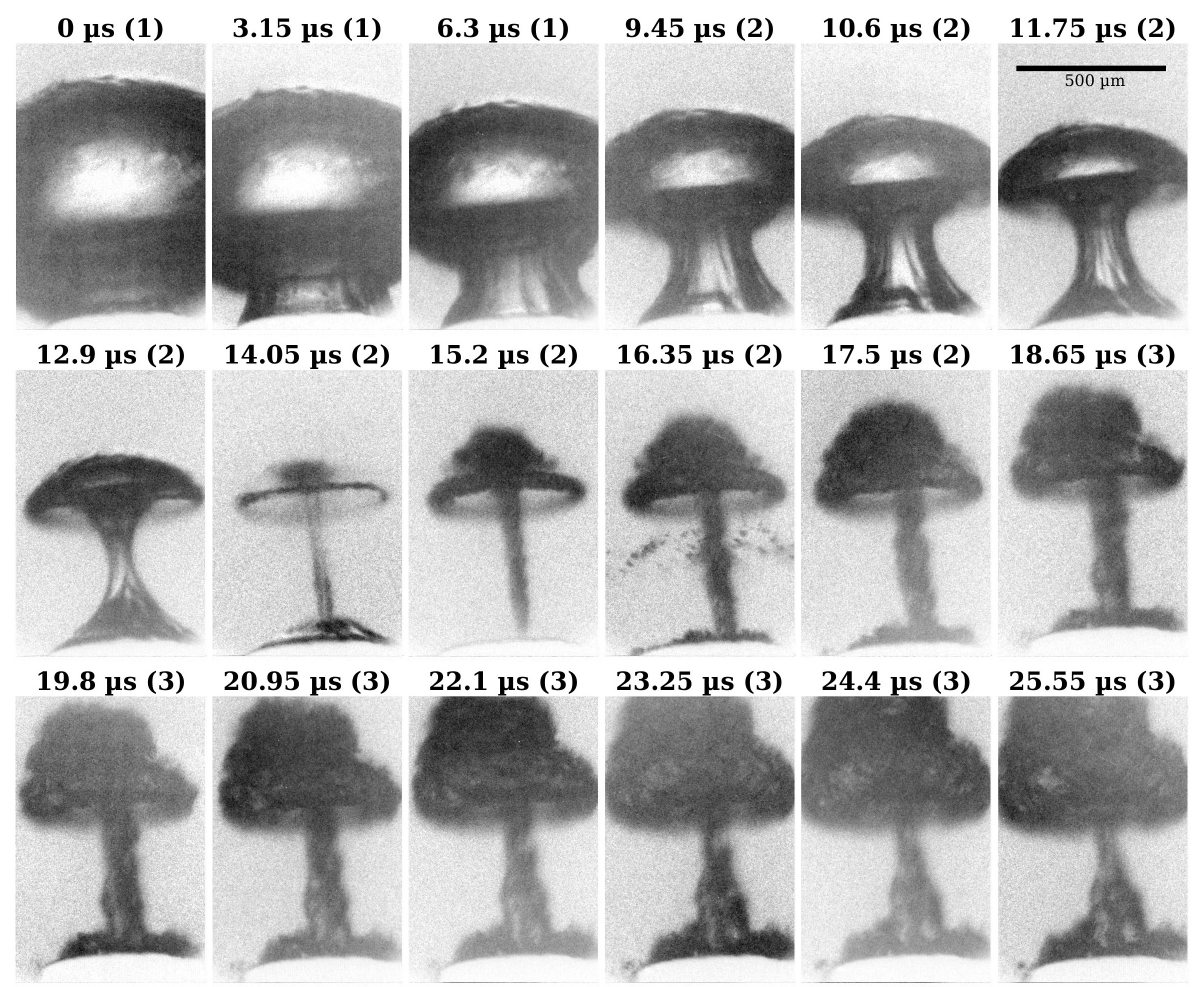
Figure 5. Experimental images of a mushroom bubble at D ∗ ≈ 0 similar to Figure 4, but recorded with the substantially higher frame rate of the IMACON camera. Exposure time is 150ns. Sequences of three recordings are stacked together. The respective recording numbers are denoted in parentheses. Frame rates for the sequences are: (1) 317kfps and for (2) and (3) 870kfps. Background of the images was subtracted; then the space occupied by the needle is shown in white pixels. Frame width is 633.5µm ± 6.9µm.